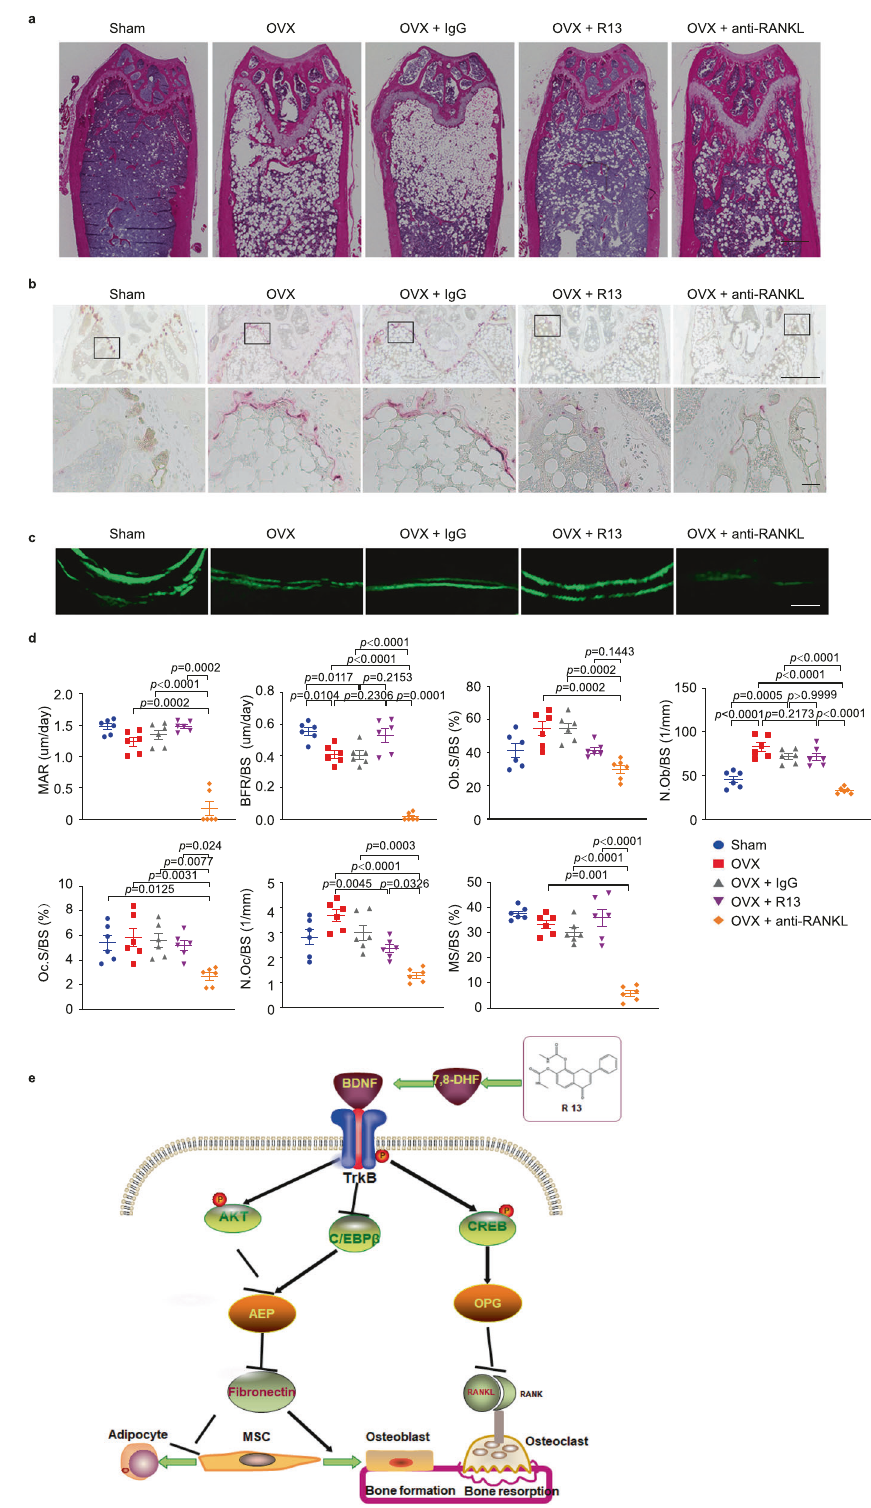
Fig. 8 | R13 and anti-RANK-L antibody treatments block the changes in bone turnover induced by ovariectomy in female mice. a Representative images of hematoxylin and eosin (H&E) staining of the distal femur bone in WT mice with sham, OVX, OVX+IgG, OVX+R13, and OVX+anti-RANK-L antibody group ( n =5 micepergroup).(Scalebar,500 μ m). b Representativeimagesoftartrateresistant acid phosphatase-stained (TRAP-stained) sections of the distal femur bone were shown at low magni fi cation (upper panel) and higher magni fi cation (lower panel) ( n =5 mice per group). (Scale bar, 500 μ m (upper panels), 20 μ m (lower panels)).